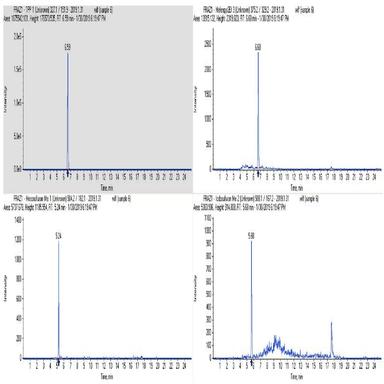
OD formulation: Mesosulfuron-methyl, Mefenpir-diethyl and Iodosulfuron-methyl-sodium by LC-MS/MS in pristine form a) and 1st fraction eluted by AF4- FFF-MALS b).